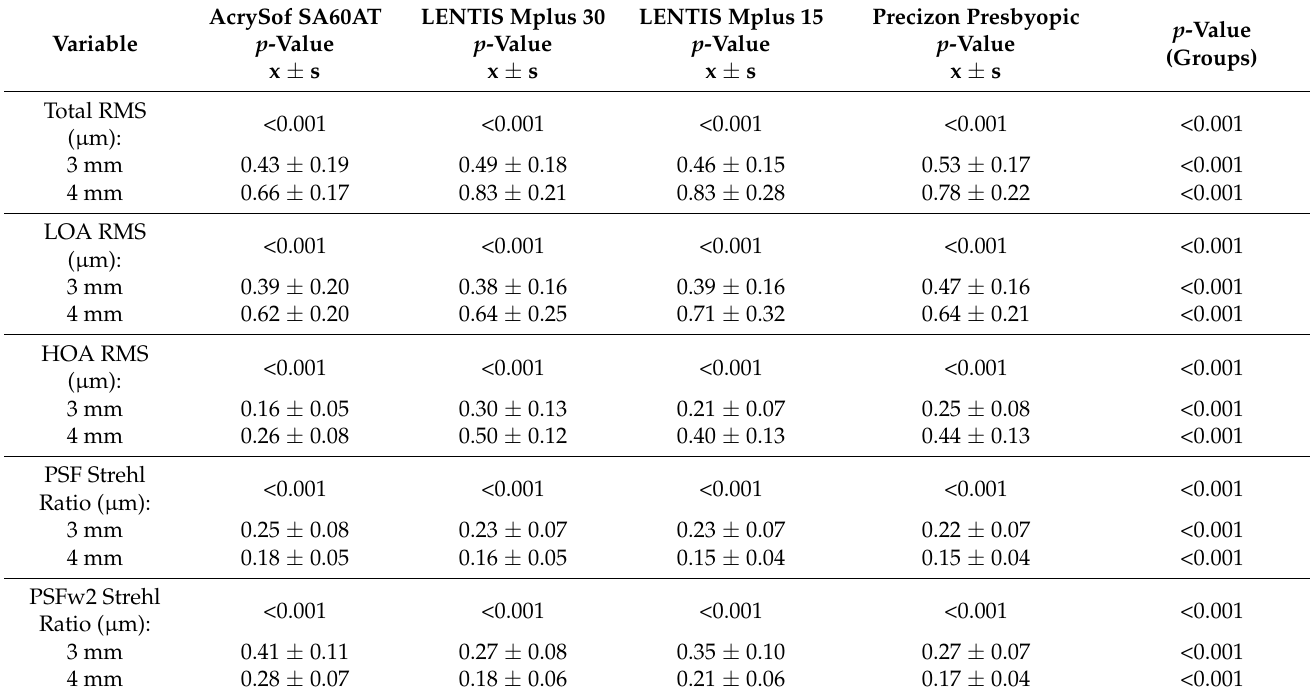
Table 2. Postoperative values of wave-front aberrations of the analyzed intervention groups at two pupil sizes obtained at 3 months. Abbreviations: HOA, High-order aberration; LOA, low-order aberration; MTF, Modulation transfer function; PSF, Point spread function; PSFw2, Point spread function without second-order aberrations; RMS, root mean square; x ± s, mean ± standard deviation.